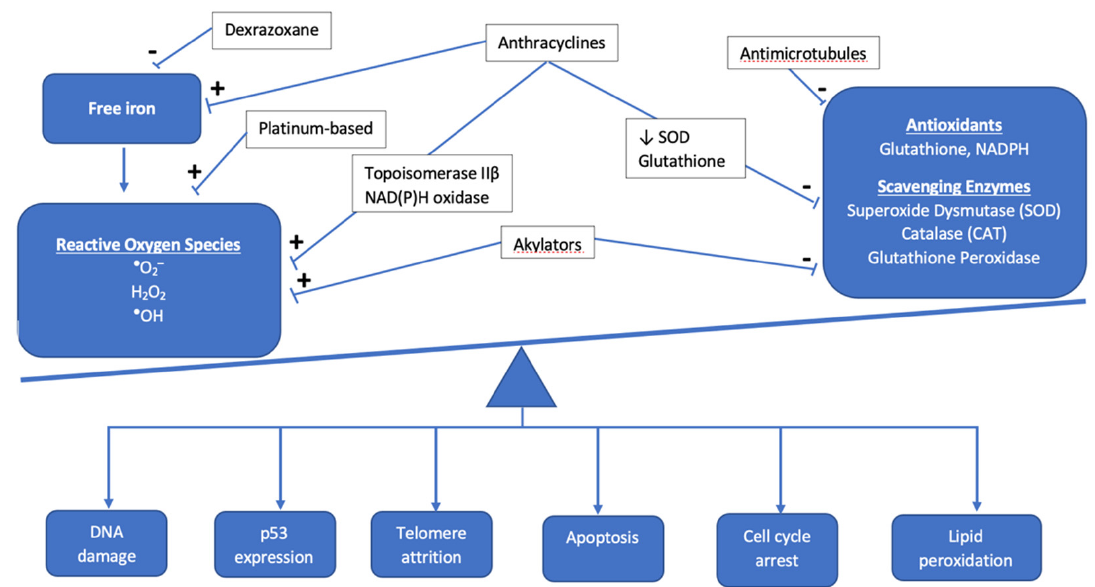
Figure 1. Overview of the interaction between antineoplastic chemotherapy and the role of oxidative stress in development of cardiotoxicity. The cumulative effect of chemotherapeutic agents results in the accumulation of reactive oxygen species and other mediators of oxidative stress, such as free iron, as antioxidants and scavenging enzymes are prevented from maintaining proper balance as they normally do under healthy physiologic conditions.